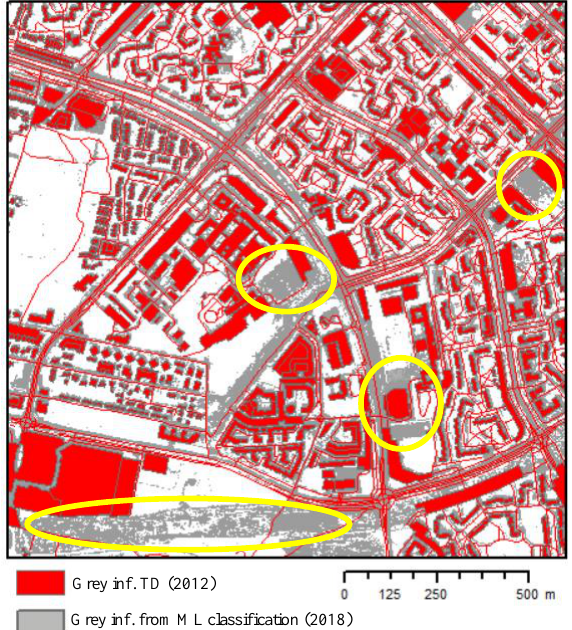
Grey inf. TD (2012) Grey inf. from ML classification Figure 13. Comparison of grey infrastructure from classification and from Topographical Database. Yellow lines indicate the new constructions.